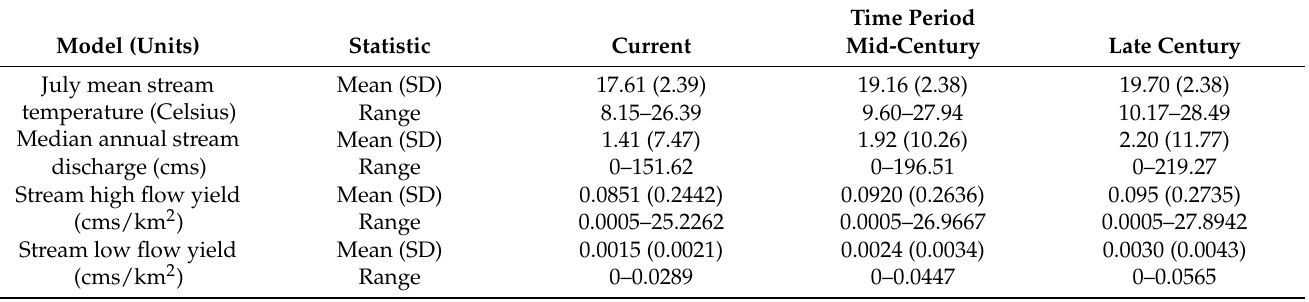
Table 1. Mean, standard deviation, and range in statewide stream temperature and flow model estimates ( n = 68,123) for current, mid-century (2046–2065), and late century (2081–2100) time peri- ods.